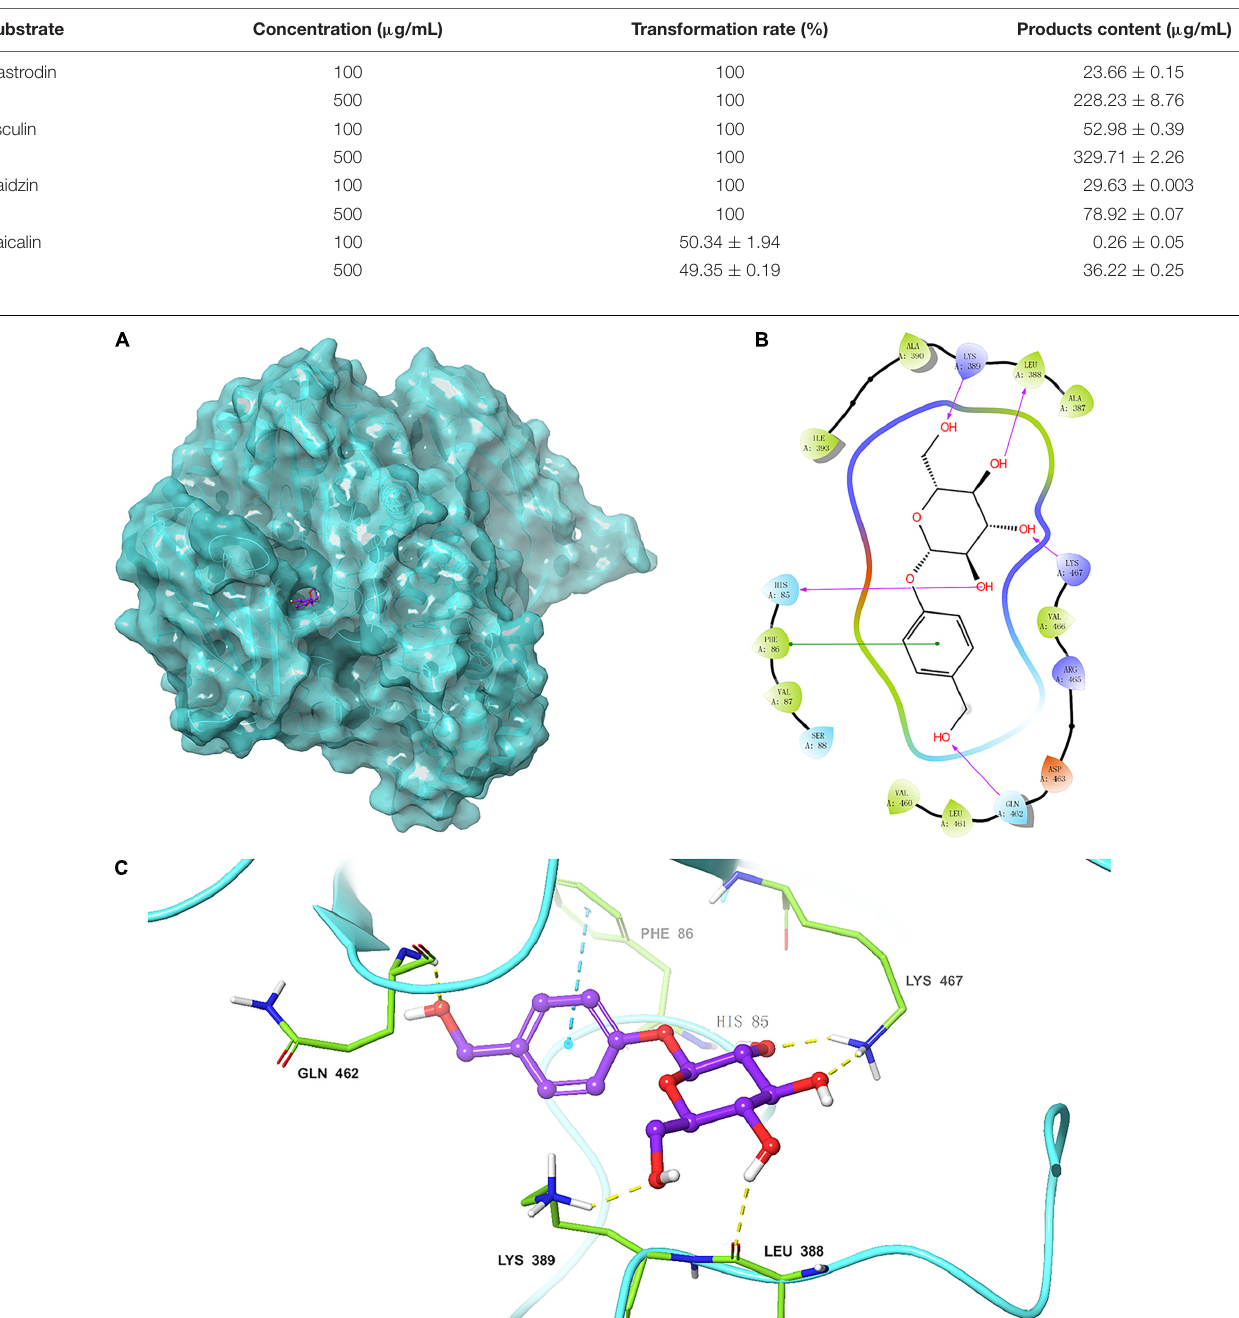
TABLE 3 | Transformation of different phenolic glycosides by recombinant TtBgl3.